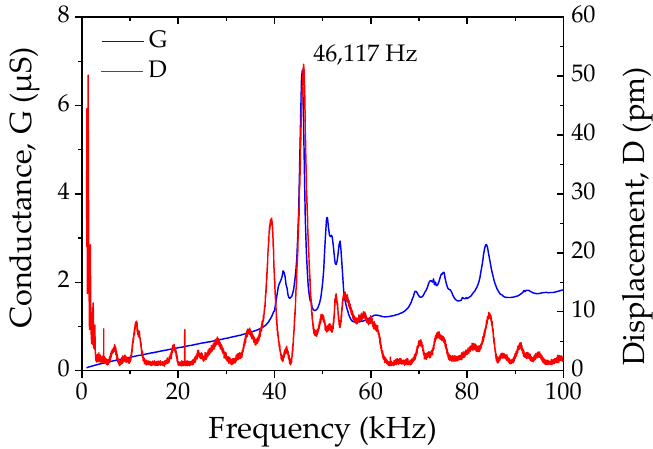
Figure 5. Conductance and displacement spectra vs. frequency recorded on the same sample (2.5 mm thick), respectively, using impedance spectrum (U = 1 V) and laser vibrometer (U = 2 V).